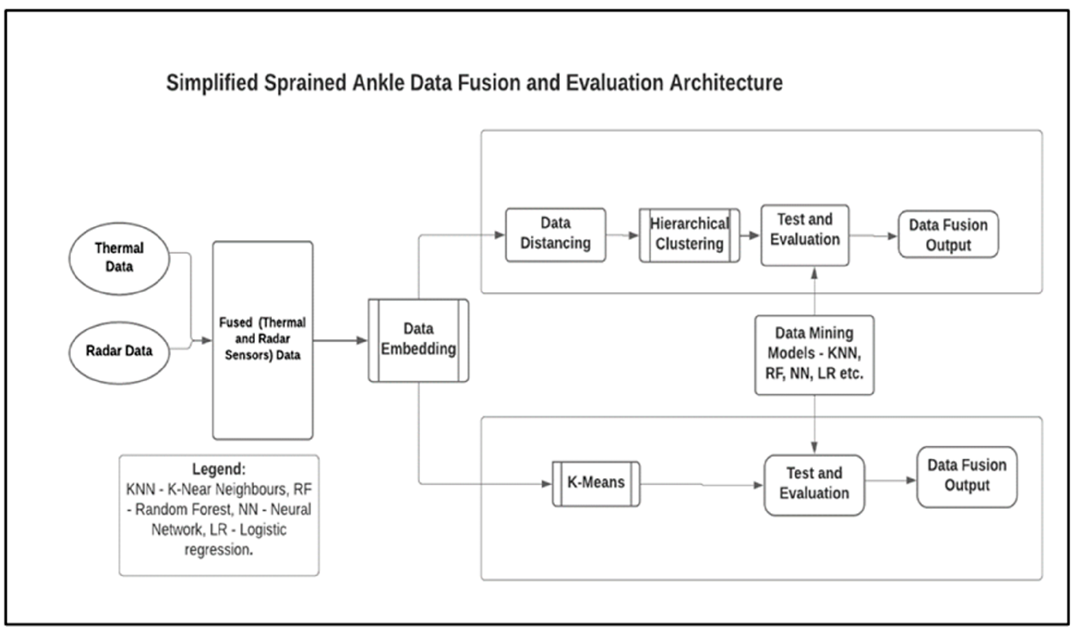
Figure 2. The Sensor Data Fusion and Evaluation Architecture.